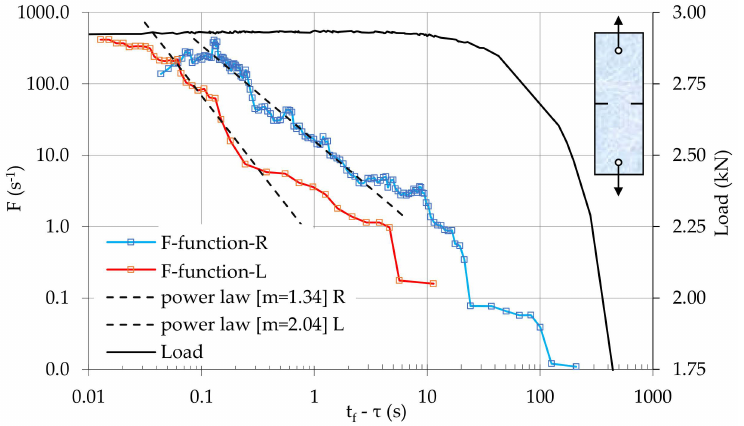
Figure 6. The temporal variation of the F-function, and the respective variation of the load applied, using the data of both acoustic